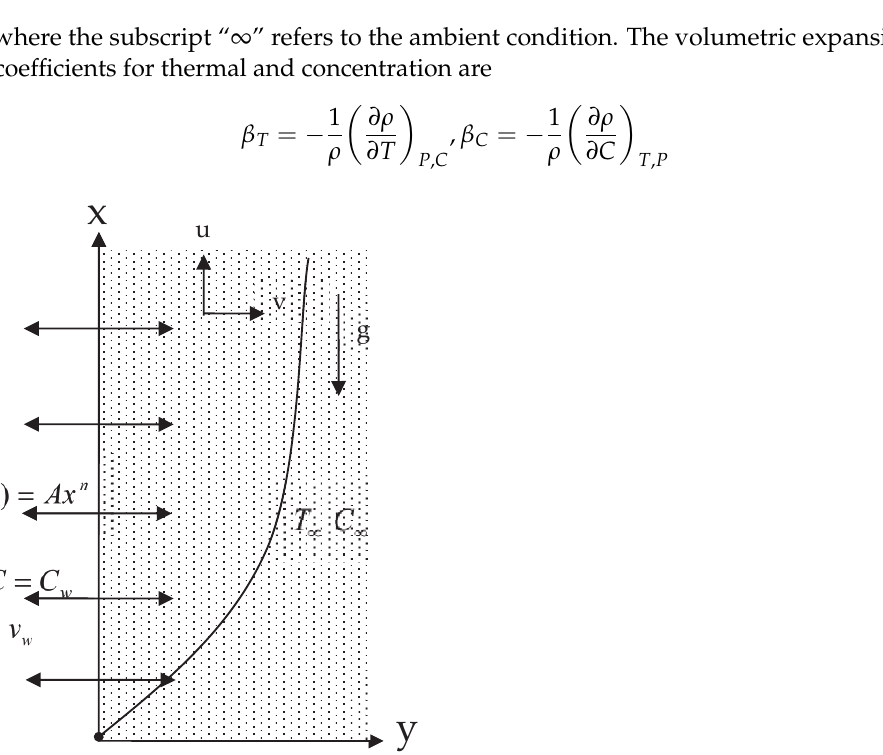
Figure 1. Schematic of natural convection flow over a vertical permeable surface physical model and coordinate system.